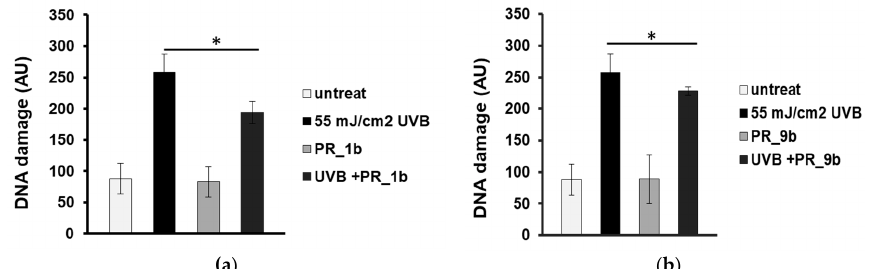
Figure 3. Propolis extracts protect HaCaT cells from UVB-induced DNA damage. Cells were pre-